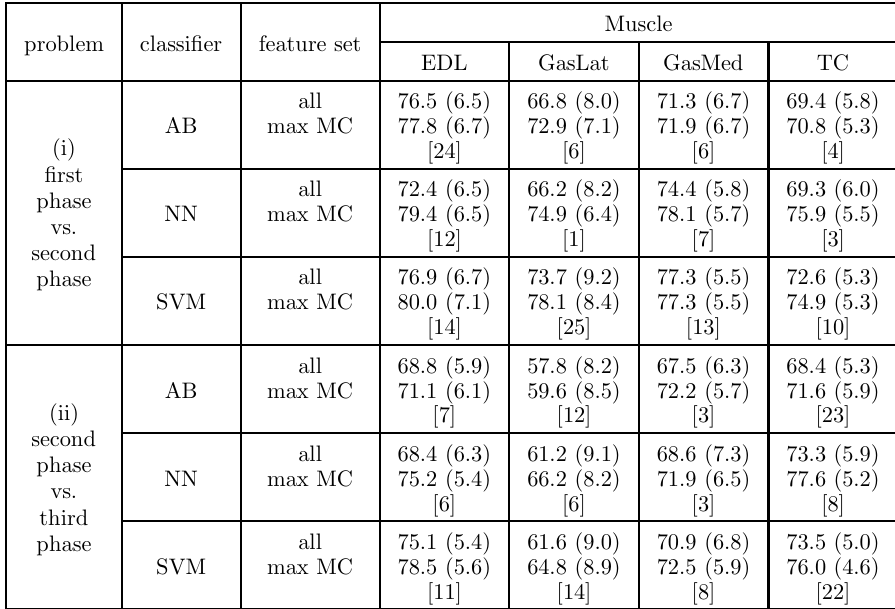
Table 7. Classification accuracies (and standard deviations) [%] achieved with age-independent features, separately for each differentiation